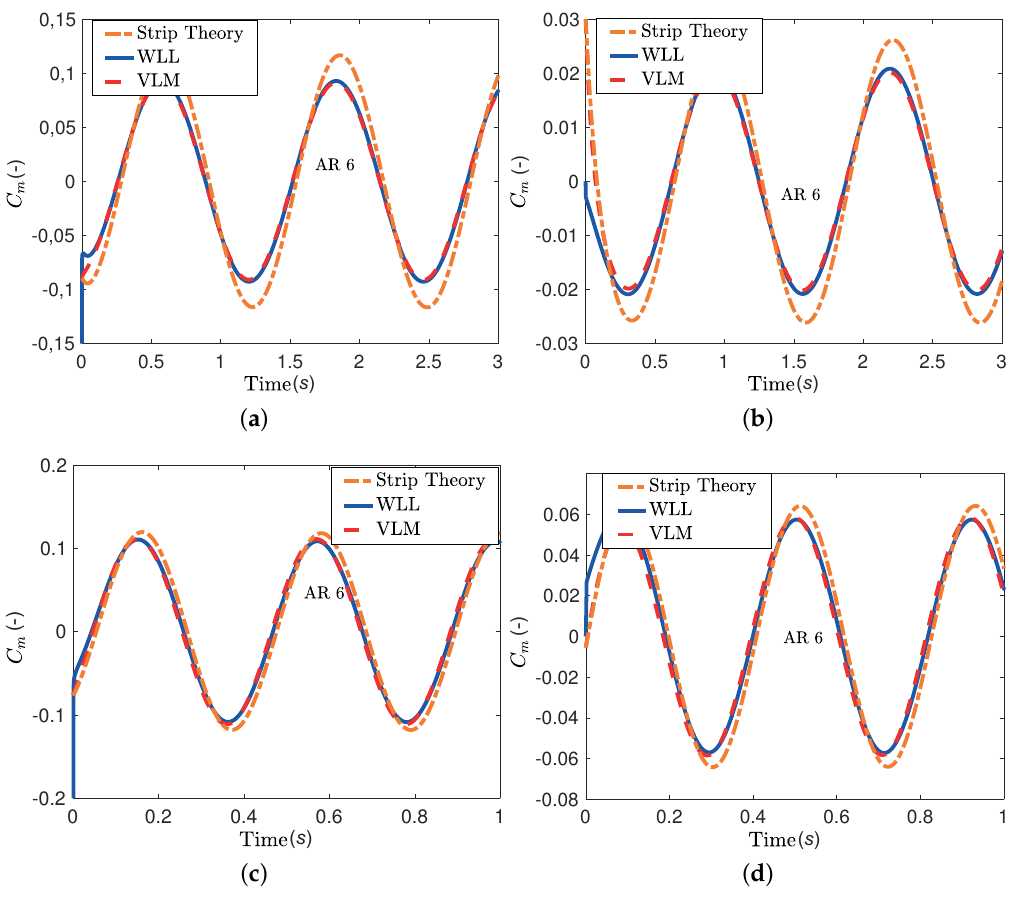
Figure 9. Moment comparison between VLM, WLL and strip theory for a rectangular wing undergoing an oscillation motion. ( a ) Oscillation in pitch with A = 5 ◦ and k = 0.1; ( b ) Oscillation in plunge with A = 0.1 m and k = 0.1; ( c ) Oscillation in pitch with A = 5 ◦ and k = 0.3; ( d ) Oscillation in plunge with A = 0.1 m and k =